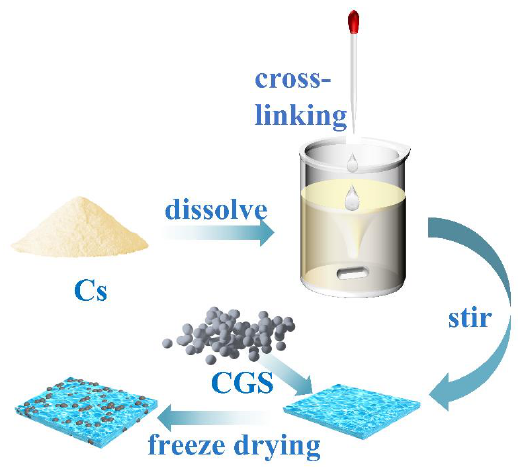
Figure 1. Route for the chitosan/CGS composite membrane.